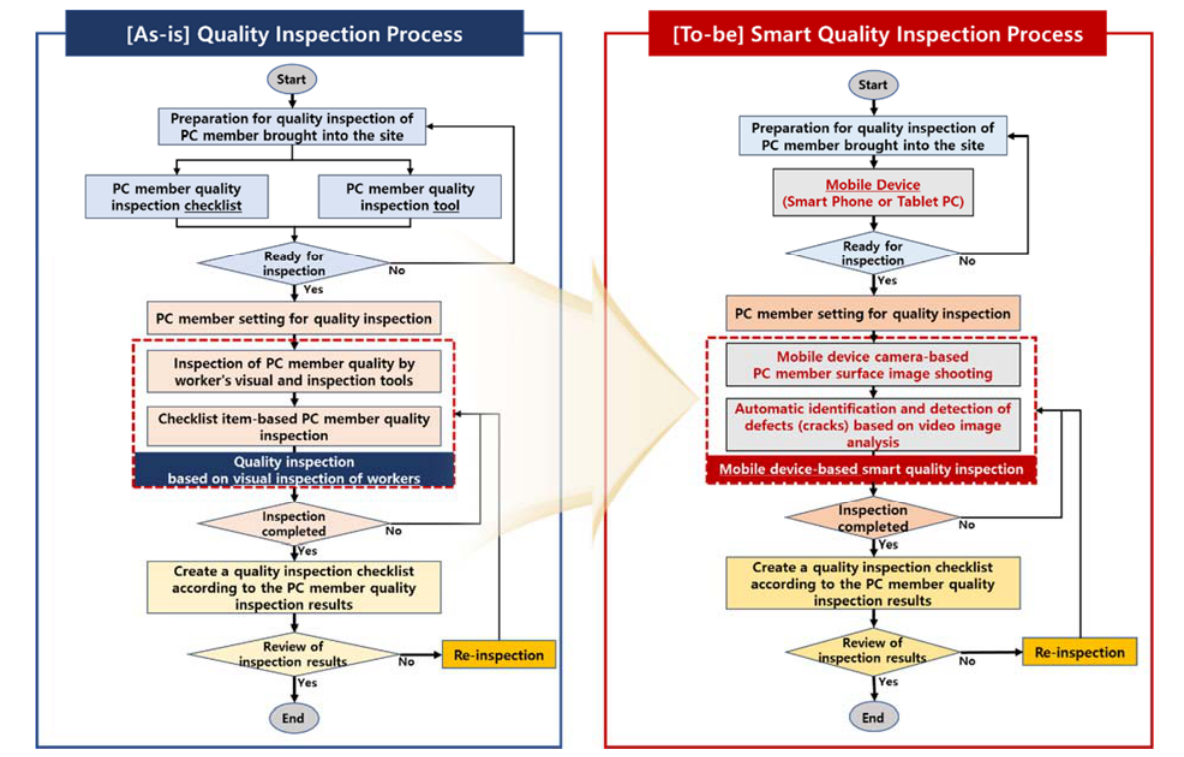
Figure 11. Comparison of As ‐ is vs. To ‐ be quality inspection process.